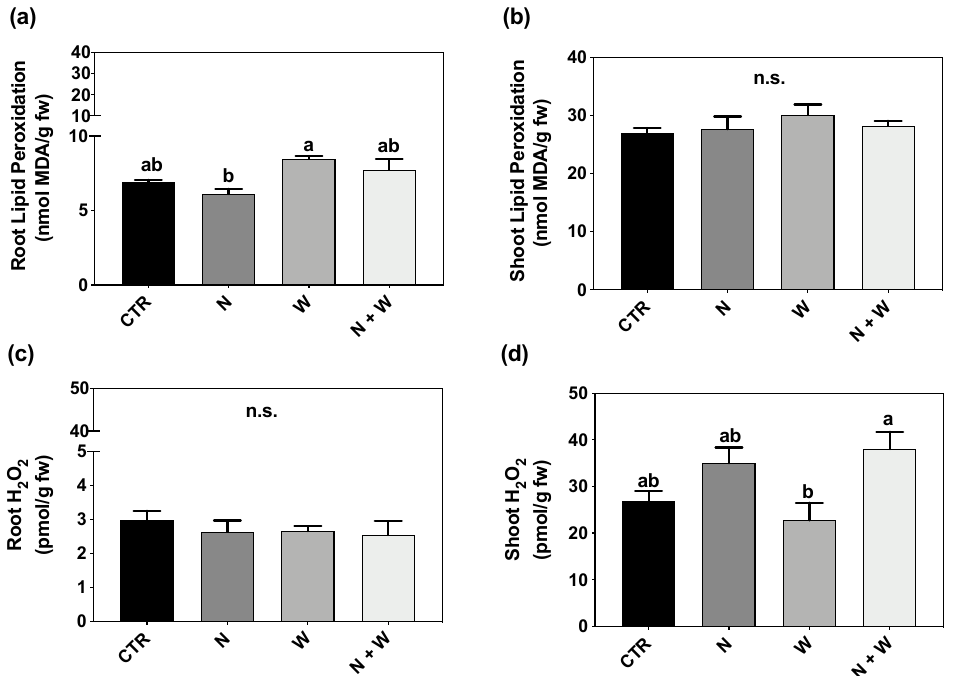
Figure 4. Lipid peroxidation of roots ( a ) and shoots ( b ) and H 2 O 2 content of roots ( c ) and shoots ( d ) of tomato plants cv. Micro-Tom grown for 16 days under control (CTR; 10.5 mM N + 100% W), nitrogen deficit (N; 5.3 mM N + 100% W), water deficit (W; 10.5 mM N + 50% W) or combined nitrogen and water deficit (N + W; 5.3 mM N + 50% W). Data presented are mean ± SEM ( n = 3). Different letters above bars indicate significant differences, and n.s. corresponds to non-significant differences between treatments according to Tukey’s HSD test ( p = 0.05).